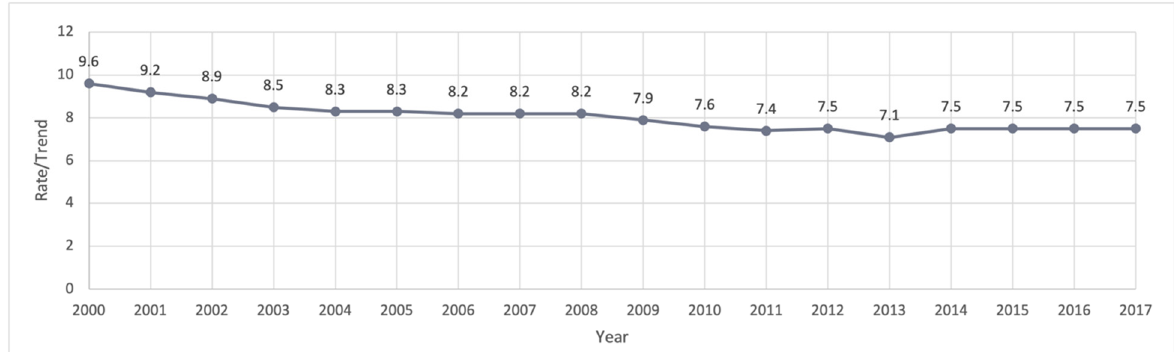
Figure 1. Incidence rate of malignant cervical cancer-SEER Research Data, 18 Registries (excl AK), November 2019 sub (2000–2017).